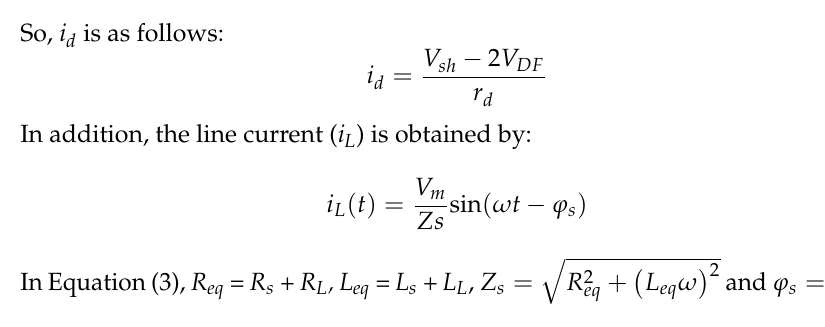
Figure 3. CDBFCL performance in both normal and fault operating